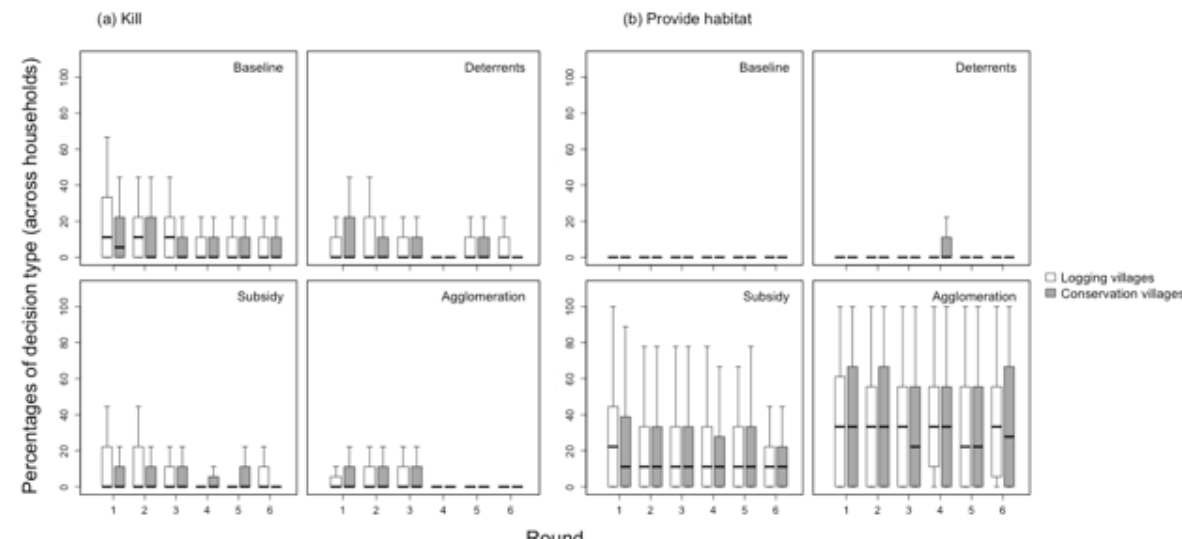
Figure A1.2: Distribution of observed percentages of decisions to kill and to provide habitats in each treatment and round, across households and groups. Solid black bars represent the median proportion, boxes the interquartile range and error bars extend to 1.5 times the IQR